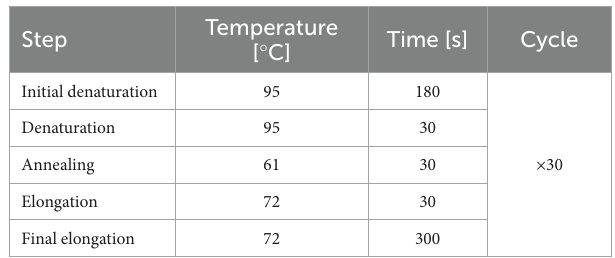
TABLE 2 PCR program for CRLF3 amplification.